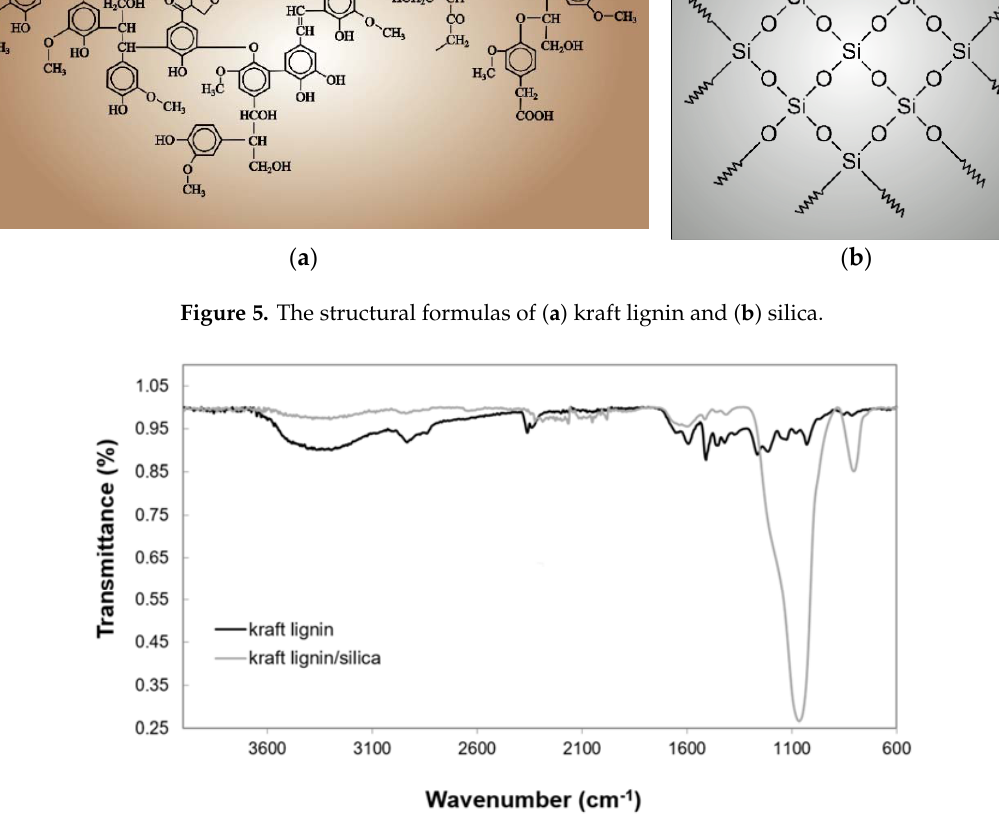
Figure 6. FTIR spectra of kraft lignin and the kraft lignin / silica system. Table 3. The elemental content of kraft lignin [18] and the kraft lignin / silica system. Carriers